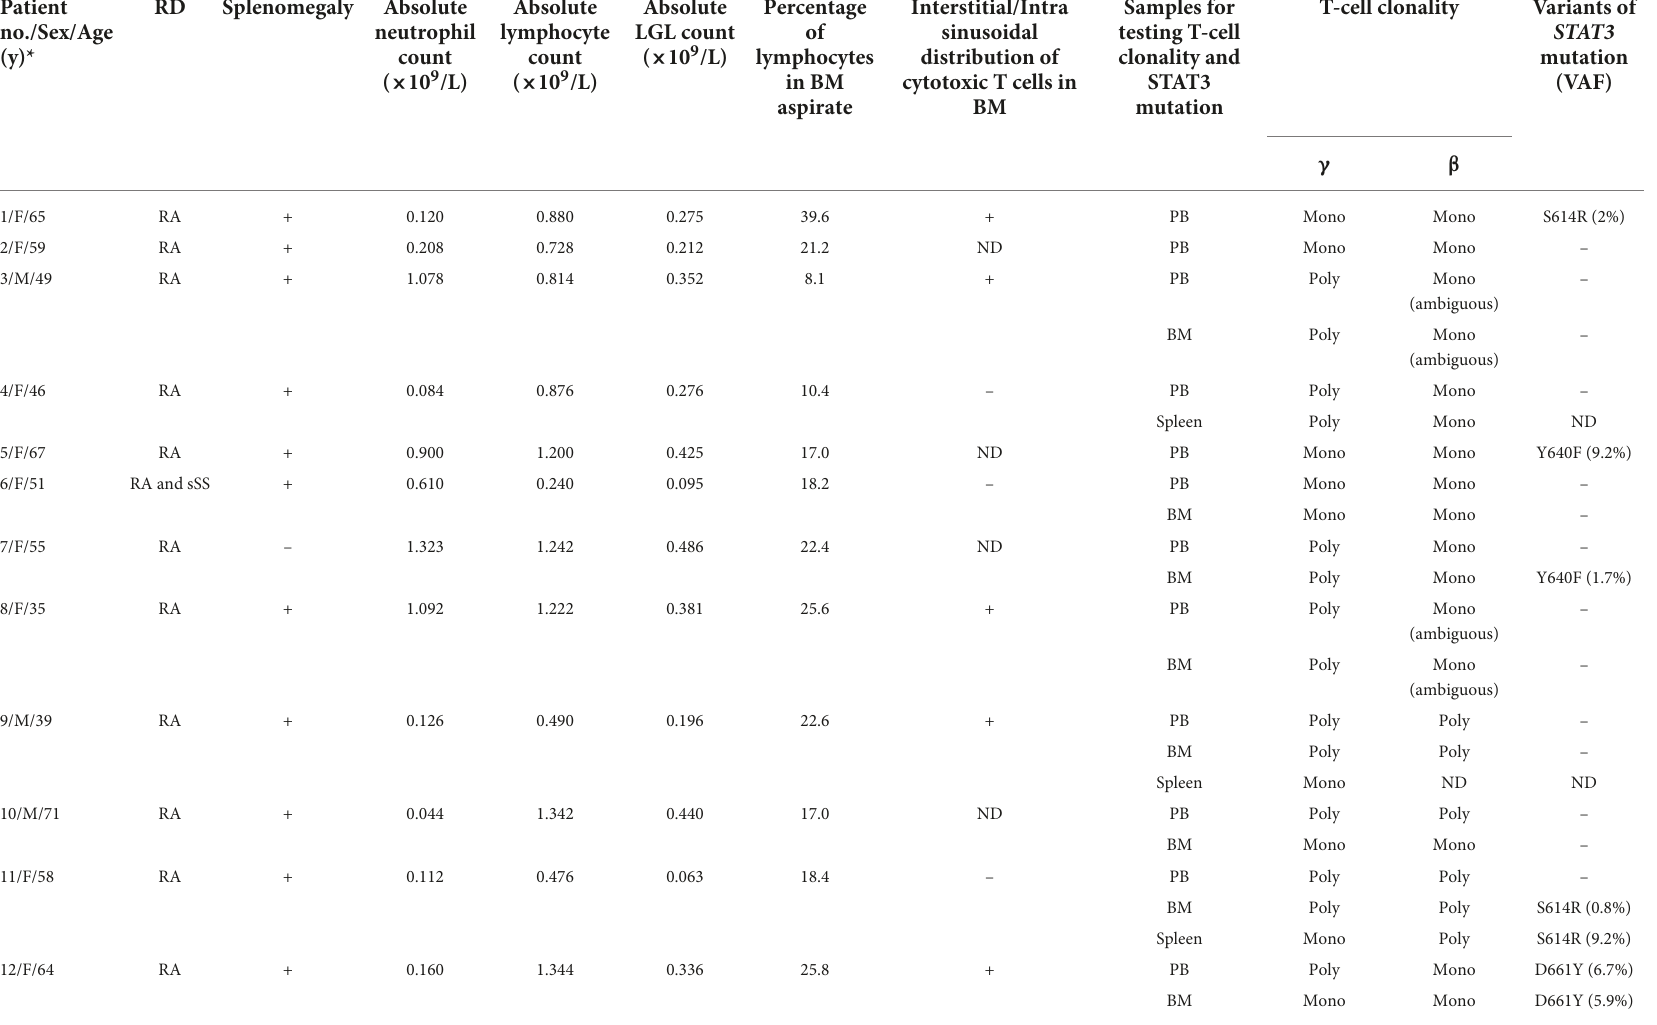
TABLE 1 Characteristics of 25 patients with rheumatic diseases, clonal T-LGL proliferations, and LGL counts of ≤ 0.5 × 10 9 /L in blood. Patient